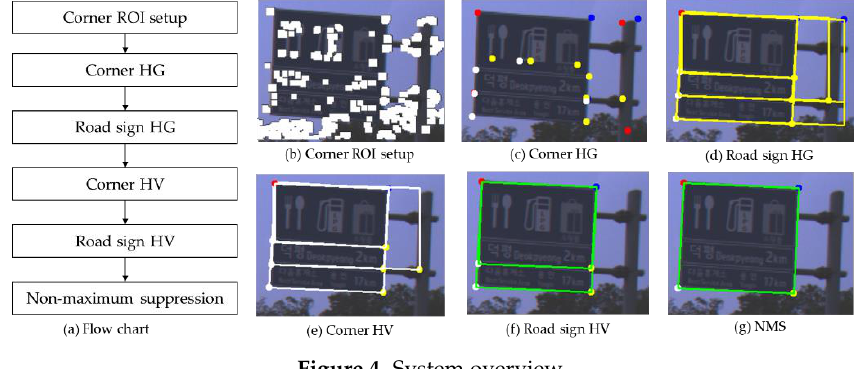
Table 1. Comparison of general corner detectors.